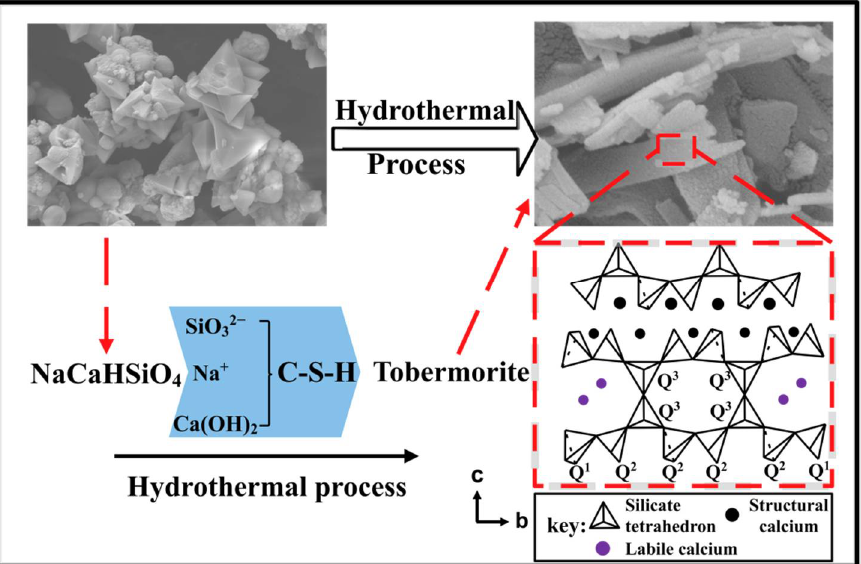
Figure 7. The schematic of the Tobermorite adsorbent (TA) preparation; Q 3 represents the bridging silicate tetrahedra; Q 2 represents mid-chain silicate tetrahedra; Q 1 represents the end group of a chain